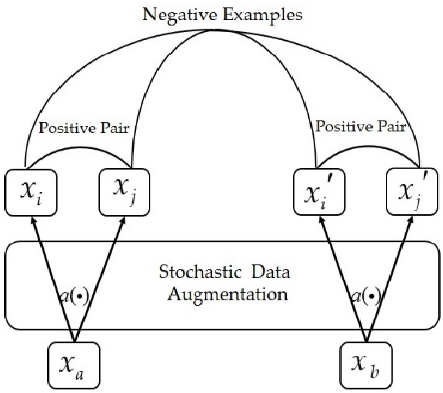
Figure 2. Negative pair and Positive pair.